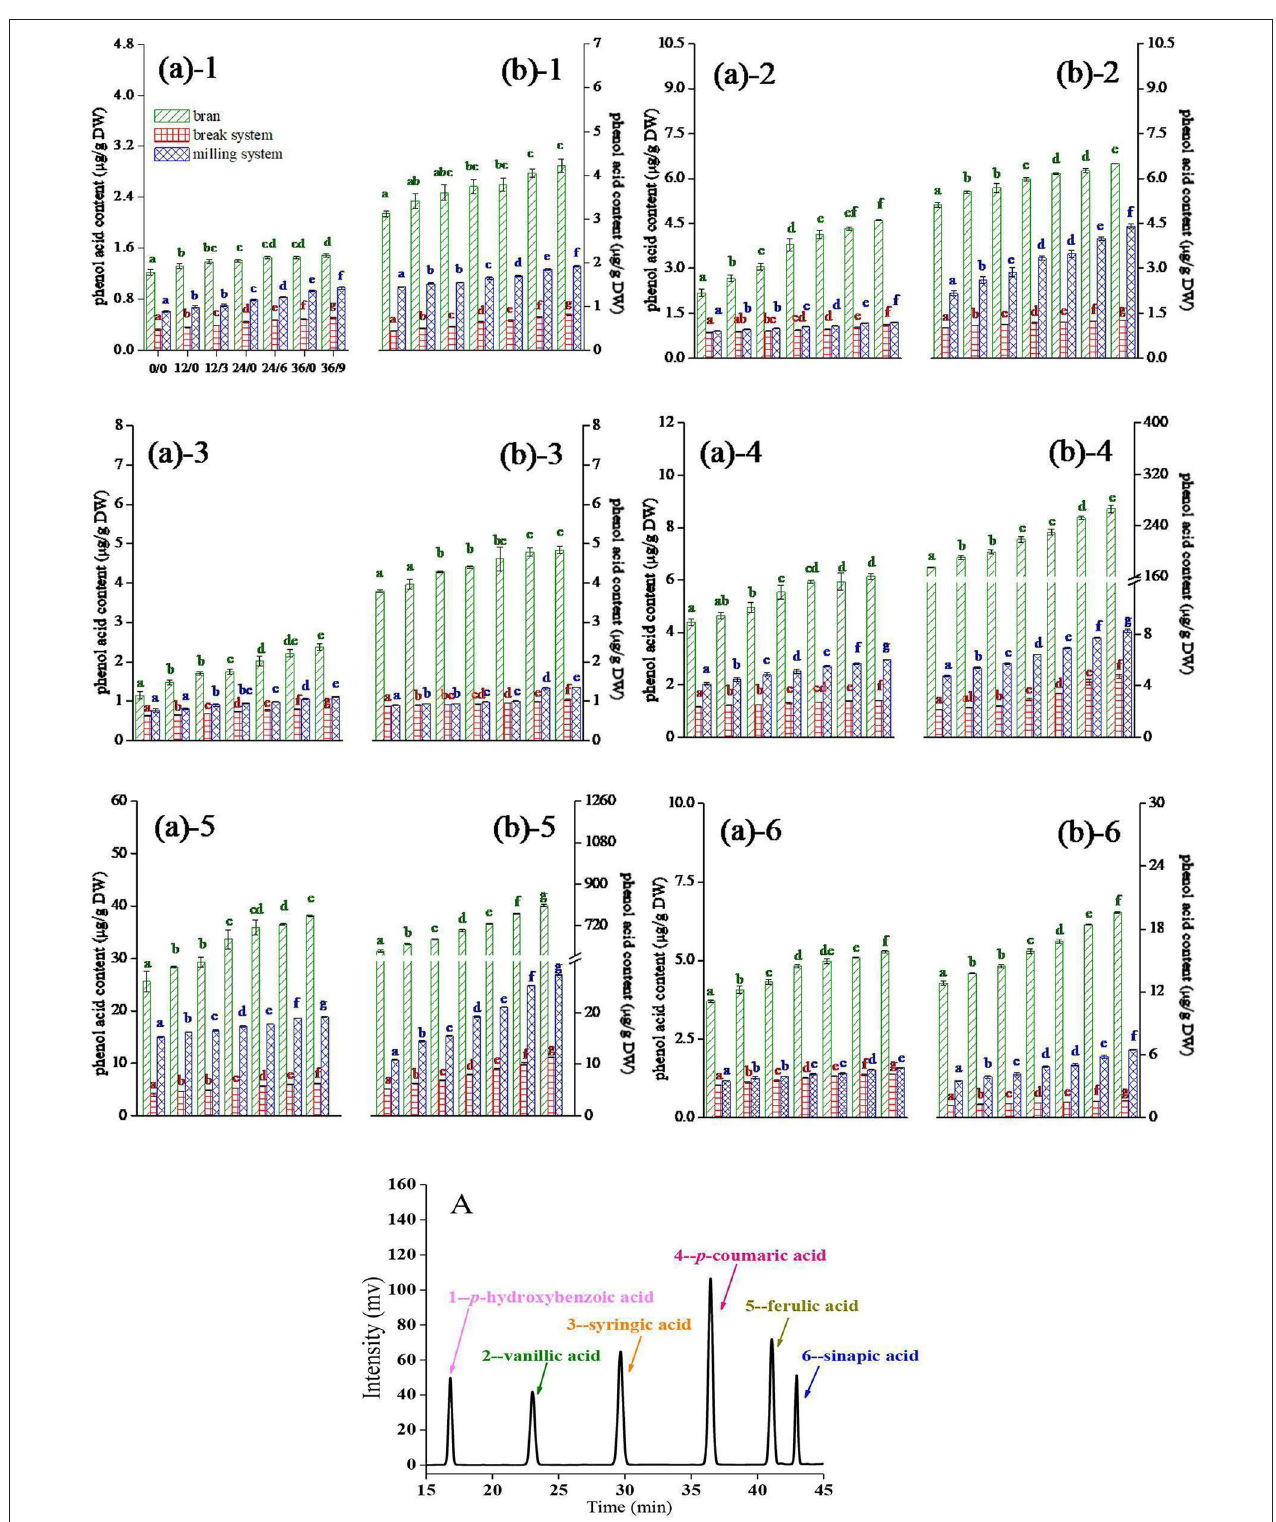
FIGURE 3 | 1– p -Hydroxybenzoic acid, 2–vanillic acid, 3–syringic acid, 4– p -coumaric acid, 5–ferulic acid, and 6–sinapic acid (in the order of retention time) contents of wheat during germination under UV-B radiation. (A) free phenol acid; (B) bound phenol acid. Bran indicates the bran flours, which is a mixture of coarse bran flours and fine bran flours. Break indicates the break system flours, which is a mixture of 1B, 2B, and 3B flours. Milling indicates the milling system flours, which is a mixture of 1M, 2M, and 3M flours. A: HPLC chromatogram of standards of six phenolic acids. Different letters indicate the results of Duncan’s multiple range test at 5% level of significant difference among different germination and UV-B radiation time,